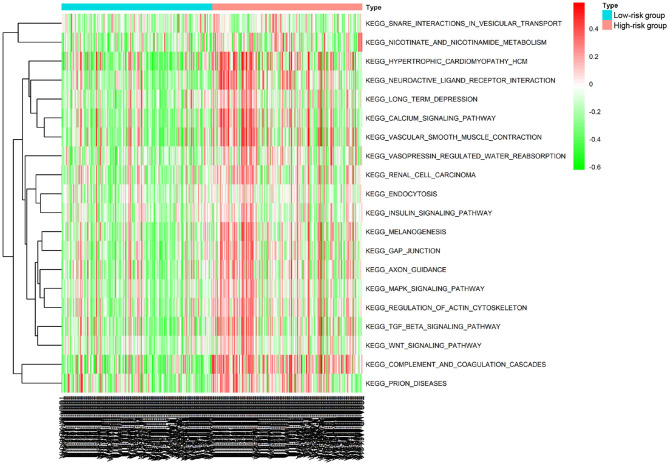
Exploration of the differences of biological behaviors between high- and low-risk groups in training set via GSVA enrichment analysis. The heatmap was used to visualize the top 20 biological processes with significant differences ranked from small to large according to P value, and red represented activated pathways and green represented inhibited pathways.